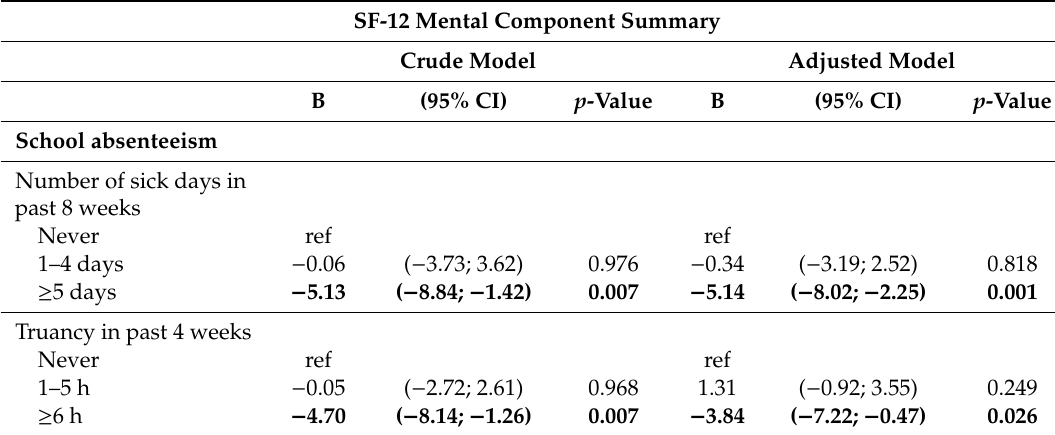
Table 2. Results from the multivariable general linear models evaluating the association of school absenteeism with mental